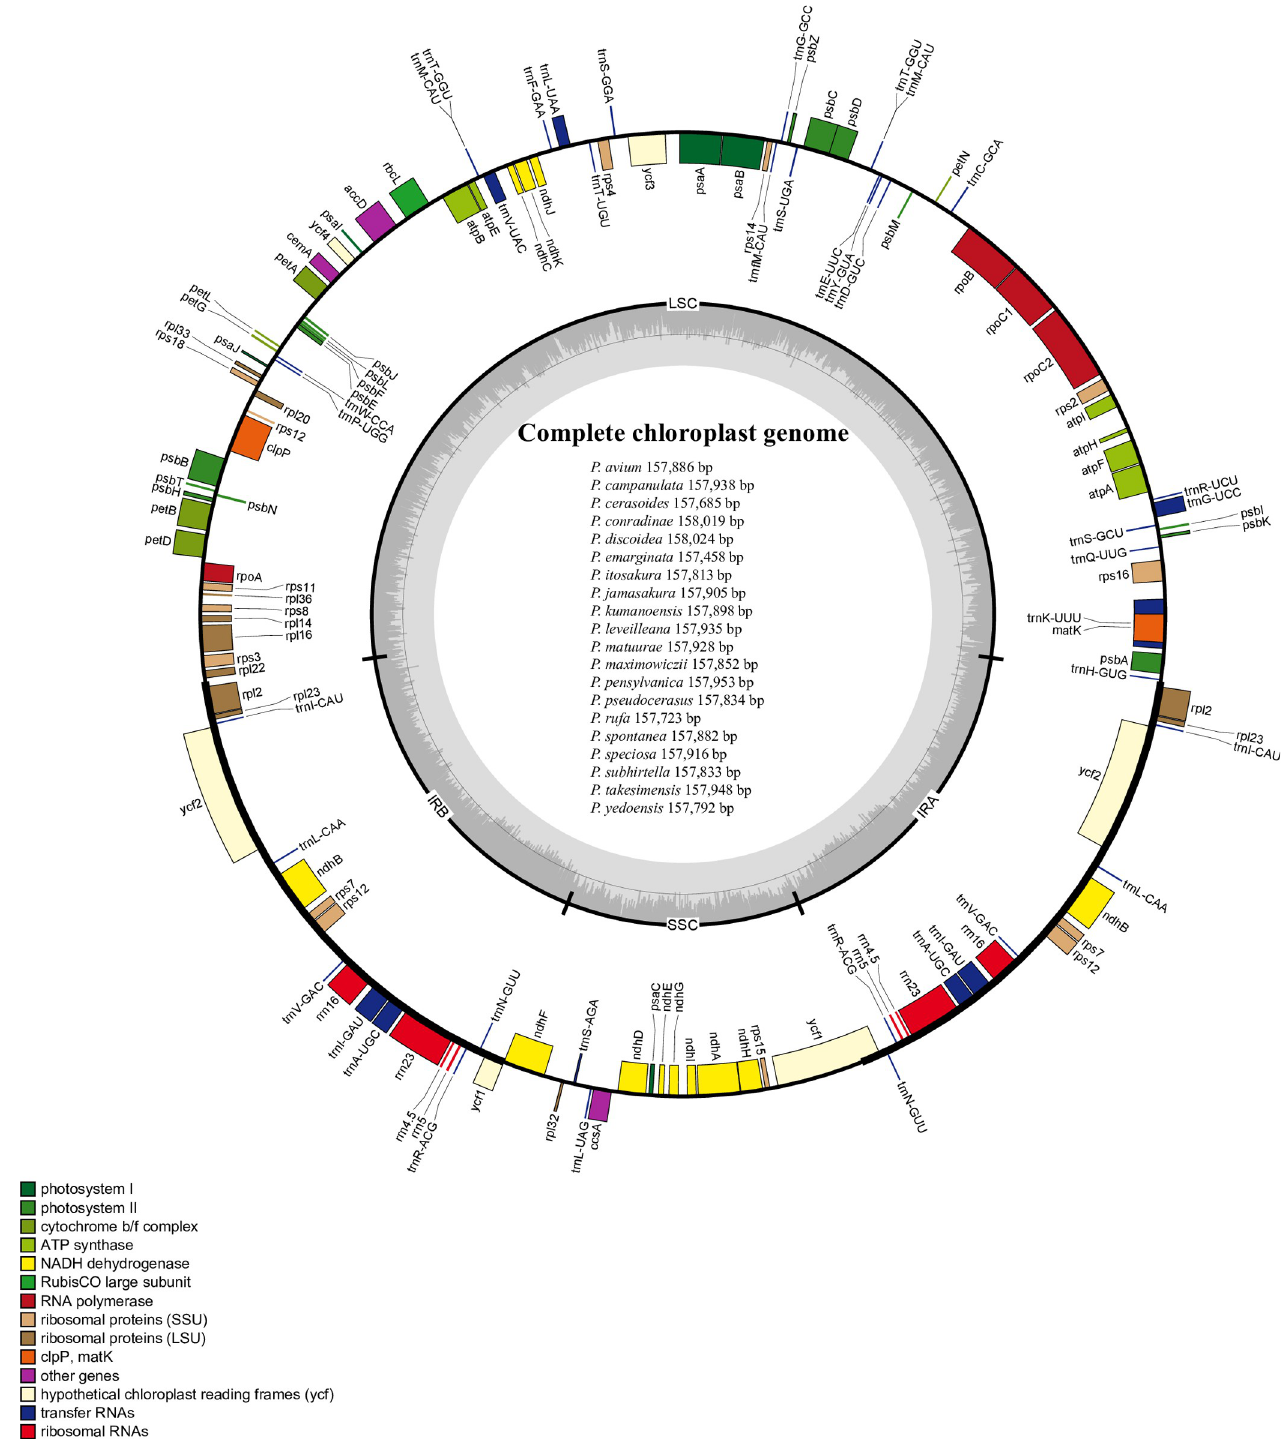
Fig 1. Plastid map of 20 subg. Cerasus species. The colored boxes represent conserved plastid genes. Genes shown inside the circle are transcribed clockwise, whereas genes outside the circle are transcribed counter-clockwise. Genes are color-coded to indicate functional groups. The dark gray area in the inner circle corresponds to GC content while the light gray corresponds to the AT content of the genome. The small (SSC) and large (LSC) single copy regions and inverted repeat (IRa and IRb) regions are noted in the inner circle.